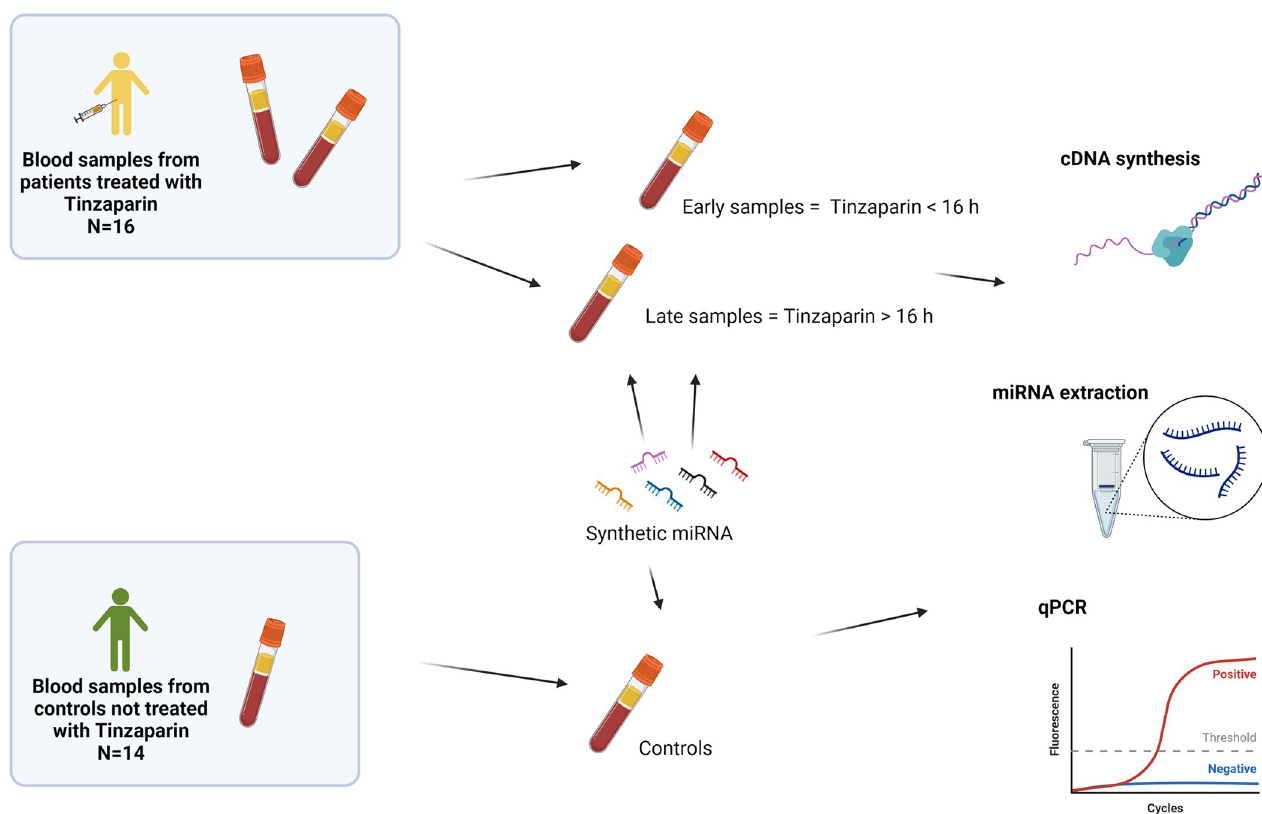
Fig 1. Graphical abstract. Graphical presentation of the study design. Sixteen fracture patients with tinzaparin treatment and 14 non-fracture controls without anticoagulation therapy. To control for the effect of tinzaparin on miRNA analysis an identical concentration of synthetic miRNAs was added to plasma, isolated RNA and prepared cDNA from all samples in both groups prior to qPCR.